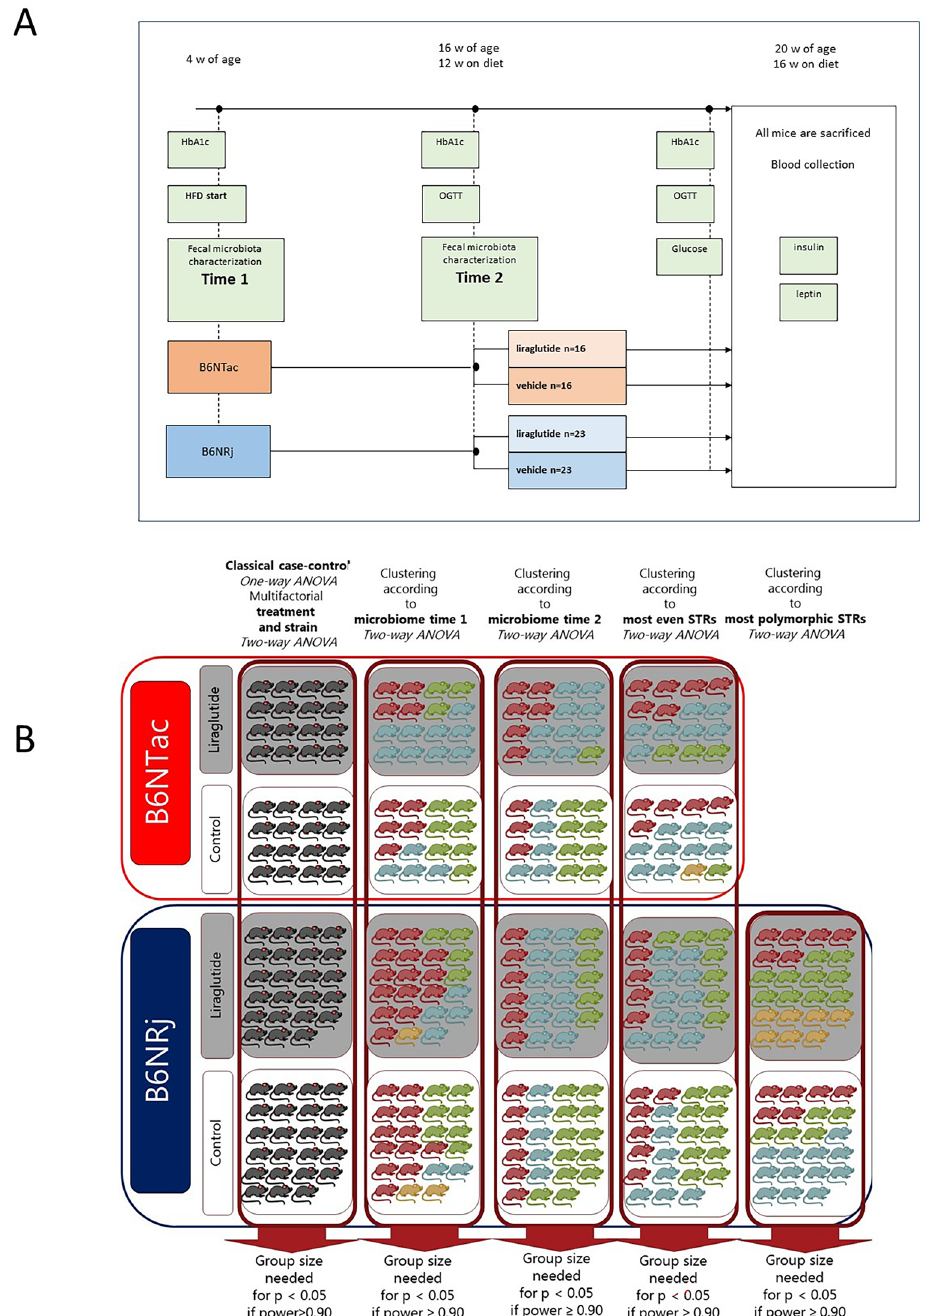
Figure 1. Overview of the study design. ( A ) Mice were shipped from the vendor at the age of four weeks. First faecal samples were collected at vendor facility (B6NTac) (mice age 3-4 weeks) or after four days of acclimatization at the experimental facility (B6NRj). First measurement of glycated haemoglobin (HbA1c) was conducted just before mice were started on high-fat diet (HFD). During the next 12 weeks of diet-induced obesity (DIO) body weight (BW) and food intake (FI) were measured weekly. Second faeces samples collection, second HbA1c measurement and first oral glucose tolerance test (OGTT) were conducted during the 12th week of DIO. Intervention with daily subcutaneous injections of liraglutide (0.4 mg/kg) started, when mice were about 16 weeks of age and lasted for 26 days. BW and FI were measured 3 times pr week and all mice were fed HFD during this period. At the end of intervention second OGTT, third measurement of HbA1c and third faecal collection were conducted. On the 27th day of intervention mice were euthanized. Fasting blood glucose was measured before the second OGTT and before euthanasia and retro-orbital blood (for insulin and leptin estimation), caecum content. ( B ) The effect of liraglutide was evaluated in C57BL/6N mice from both Taconic (Tac) and Janvier (Rj) in a classical case- control study. All mice had their fecal microbiota and genome characterized by 16S sequencing and standard tandem repeats, respectively. Statistics were made by simply comparing case (Liraglutide) with control in a one-tailed one-way ANOVA or by incorporation of clusters of microbiome at time points 1 and 2 as a factor in a two-way ANOVA. Based upon observed means and standard deviations the group size needed to obtain p < 0.05 at a power of 0.90 was evaluated. The colours of the mice illustrate the clusters they could be divided